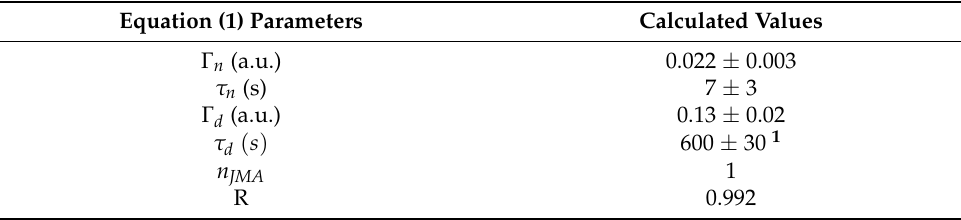
Table 1. Adsorption kinetics parameters obtained from the fit of Equation (1) to experimental